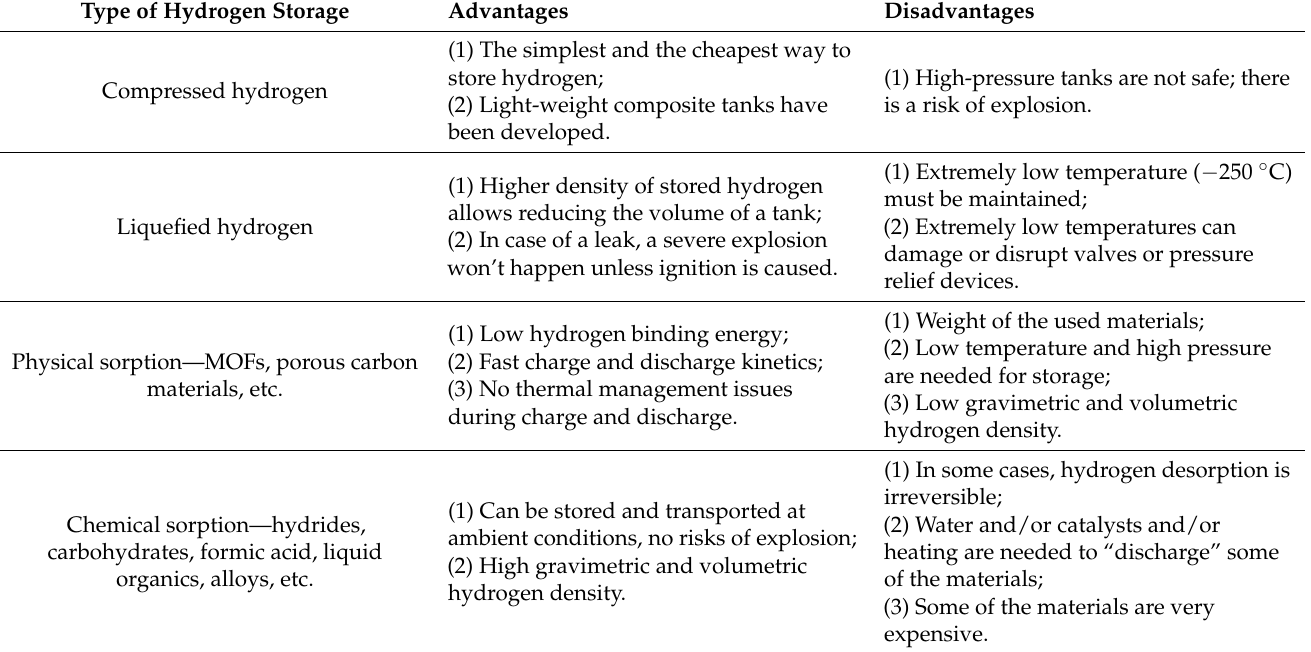
Table 6. An analysis of different hydrogen storage systems (based on [90]). Type of Hydrogen